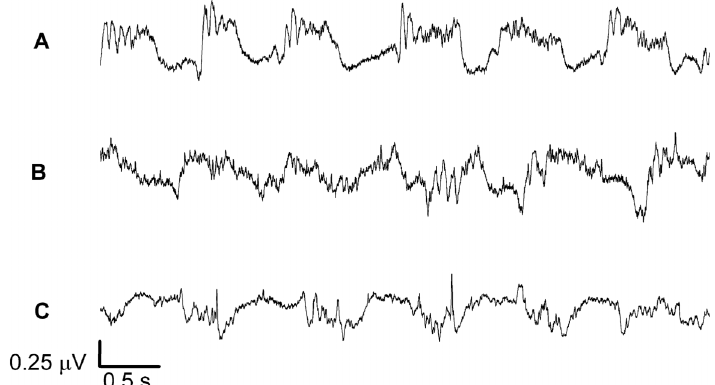
Figure 1. Electrocorticogram segment of 5 s dura- tion for the following groups: control ( A ); IR24 (irradiation evaluated at 24 h) ( B ) and IR90 (irradia- tion evaluated at 90 days) ( C